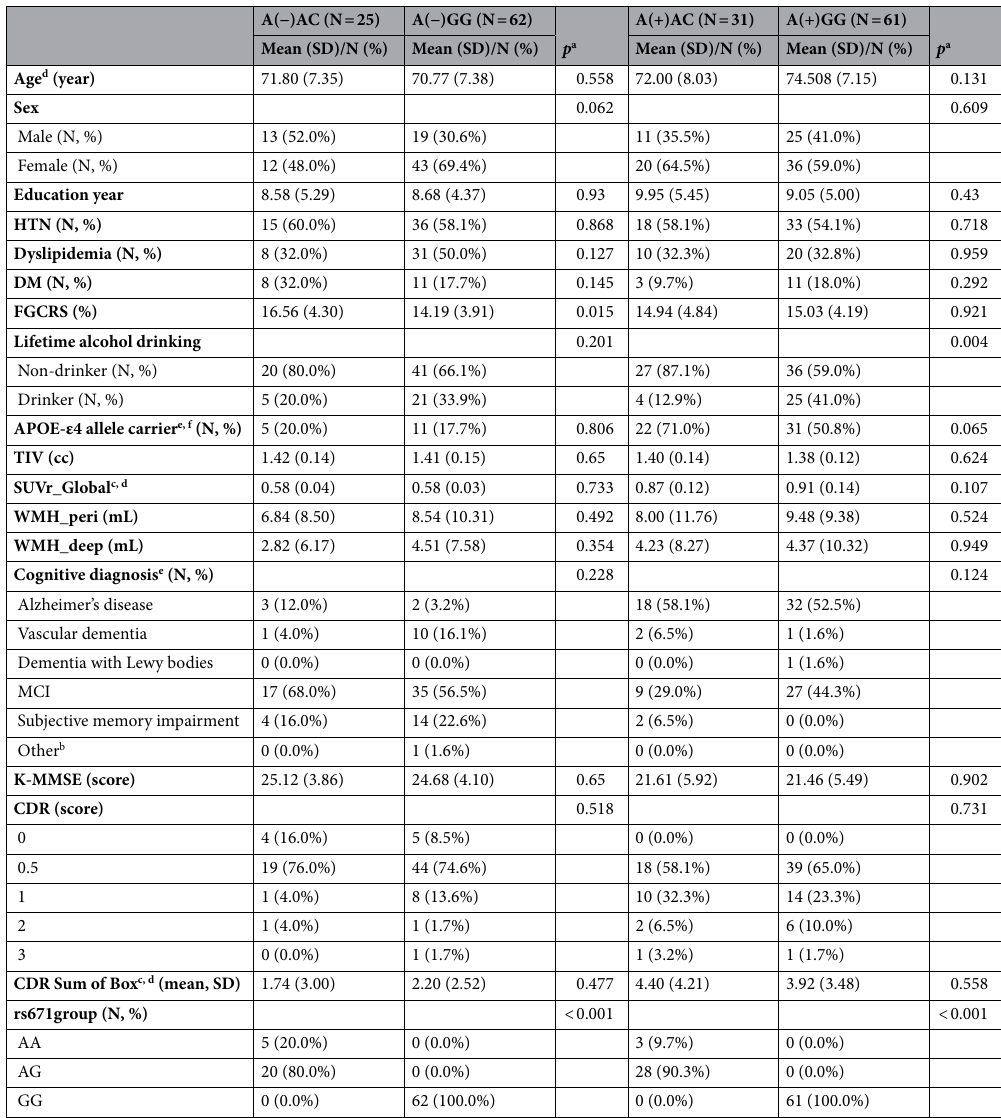
FGCRS, Framingham general cardiovascular risk score; TIV, total intracranial volume; SUVr, standardized uptake value ratio; WMH, white matter hyperintensities; MCI, mild cognitive impairment; K-MMSE, Korean-Mini Mental Status Examination; CDR, Clinical Dementia Rating. a Student’s t test was conducted for continuous variables. Chi-square tests were performed for categorical variables. b Unspecified sleep disorder. c Variable means 1 < 3 as a result of the multiple comparison with Bonferroni correction, p < 0.05. d Variable means 2 < 4 as a result of the multiple comparison with Bonferroni correction, p < 0.05. e Variable means 1 versus 3 as a result of the multiple comparison with Bonferroni correction, p < 0.05. f Variable means 2 versus 4 as a result of the multiple comparison with Bonferroni correction, p <